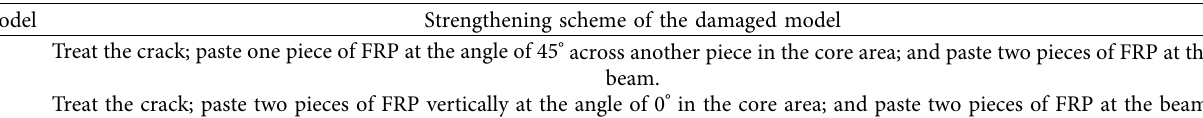
Table 3: Strengthening scheme of the joints.